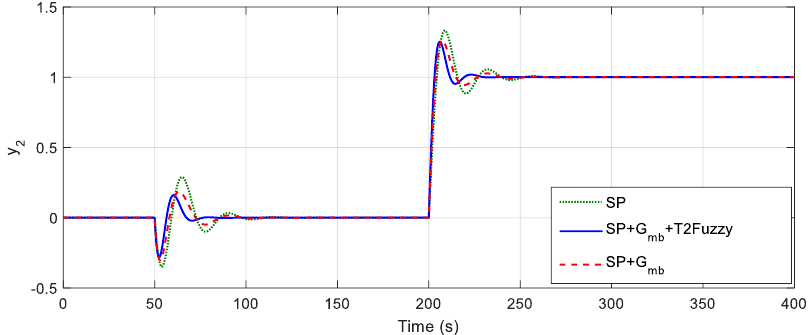
Figure 8. Performance of three control methods for 𝑦 2 for example 1.